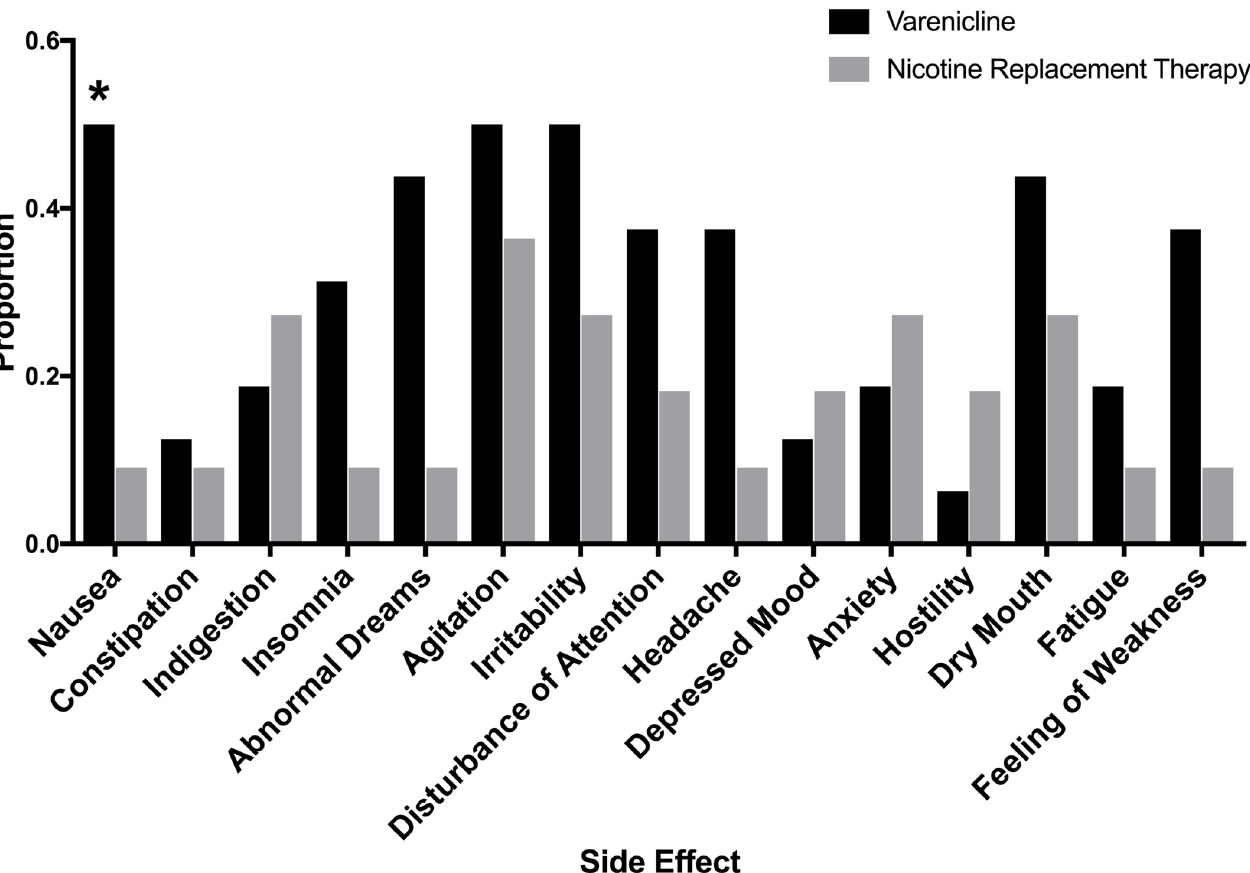
Fig 3. Side effects reported based on medication prescribed. Side effects are reported as the proportion of patients reporting new or worsening symptoms from baseline while on varenicline (black) compared with nicotine replacement therapy (grey). � p = 0.04 by the Fisher’s exact test. No other comparison between varenicline and NRT was statistically significant. Due to the low number of individuals on bupropion (n = 3) these were excluded from the figure. Participants on bupropion reported mild headache, depressed mood, and hostility (all n = 1).